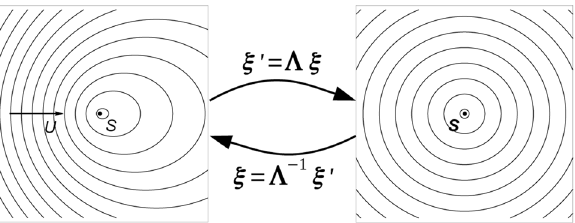
Figure 3. Spacetime coordinate transformation that maps a convective propagation pattern in the physical space into an isotropic one in the transformed